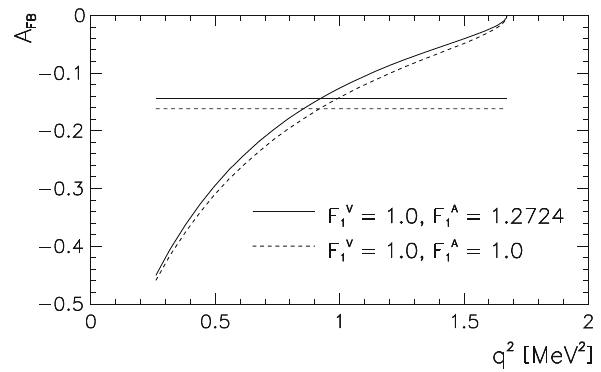
Fig. 4 Forward–backward asymmetry A FB ( q 2 ) as a function of q 2 for two different sets of form factors (solid and dashed lines). The straight lines represent the average value forward–backward asymmetry inte- grated over q 2 ∈ [ m 2 (cid:3) ,( M n − M p ) 2